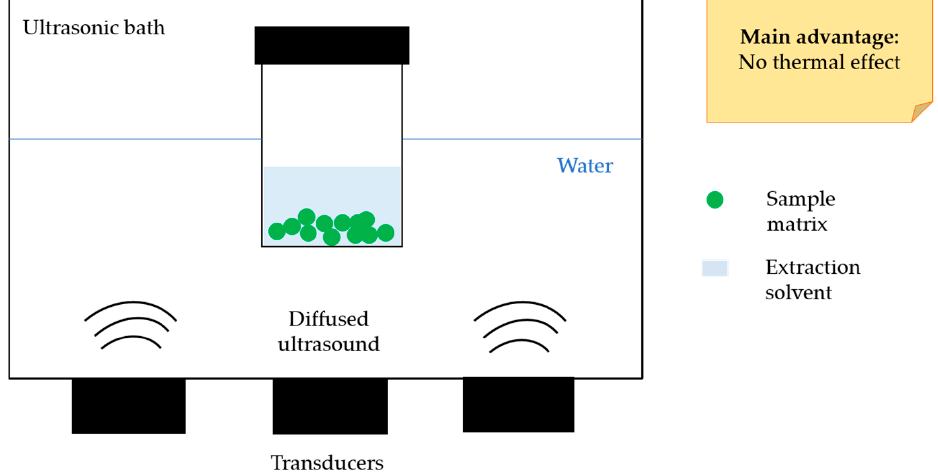
Figure 4. Schematic representation of typical UAE equipment.